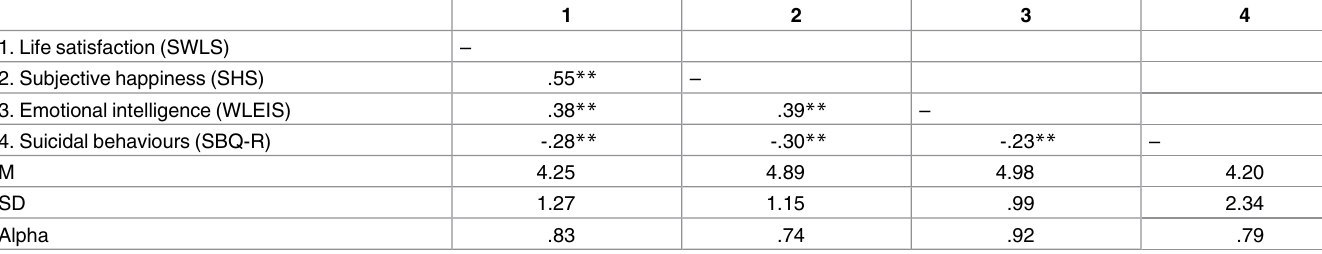
Table 1. Means, standard deviations, reliabilities and correlations of the variables of interest.